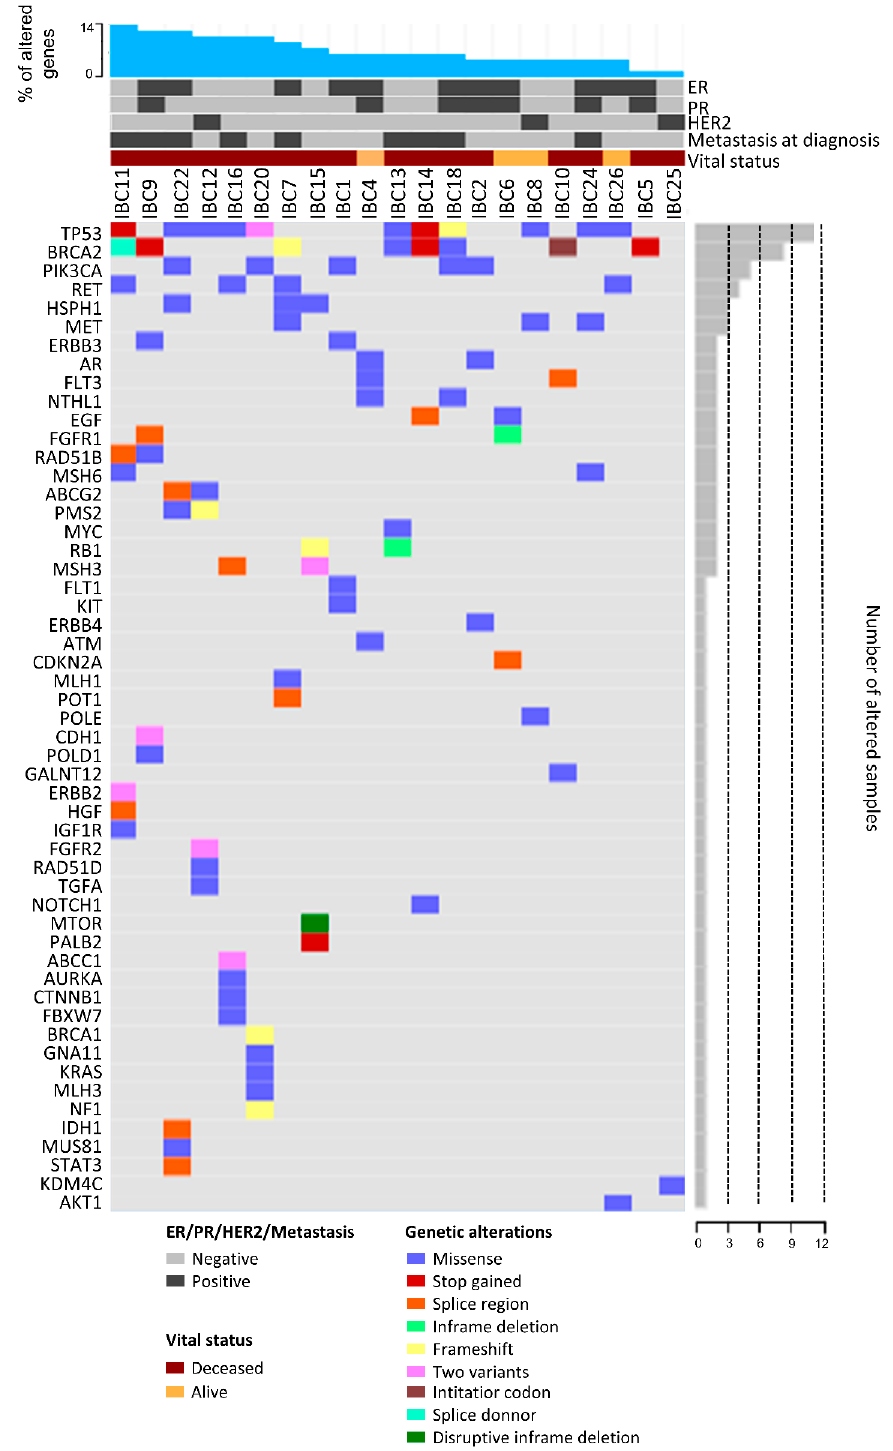
Figure 3. OncoPrint showing the 53 genes affected by mutations in the 21 IBC patients evaluated by targeted next-generation sequencing (tNGS). Patients from left to right present a decreased number of mutations (top panel), while genes from top to bottom were found mutated in a decreasing number of patients (right panel).